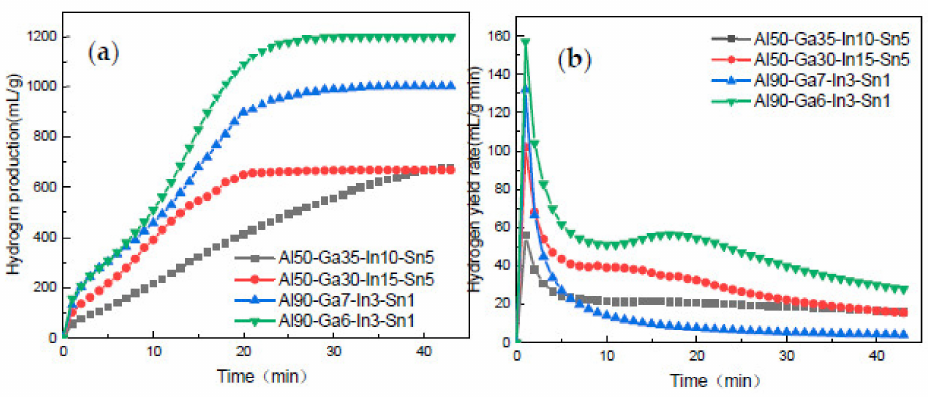
Figure 9. Comparison of hydrogen production performance of Al50 and Al90 at different GIS ratios: ( a ) hydrogen production comparison chart and ( b ) hydrogen production rate comparison